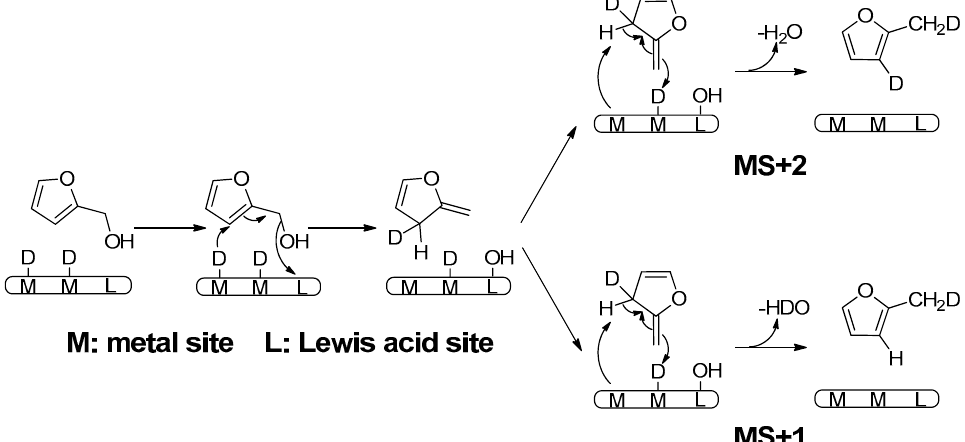
Scheme 5. Reaction mechanism for the hydrogenolysis of FA to MF over Ru/RuOx/C catalyst using isotopic lebelling. Adapted from Gilkey et al.